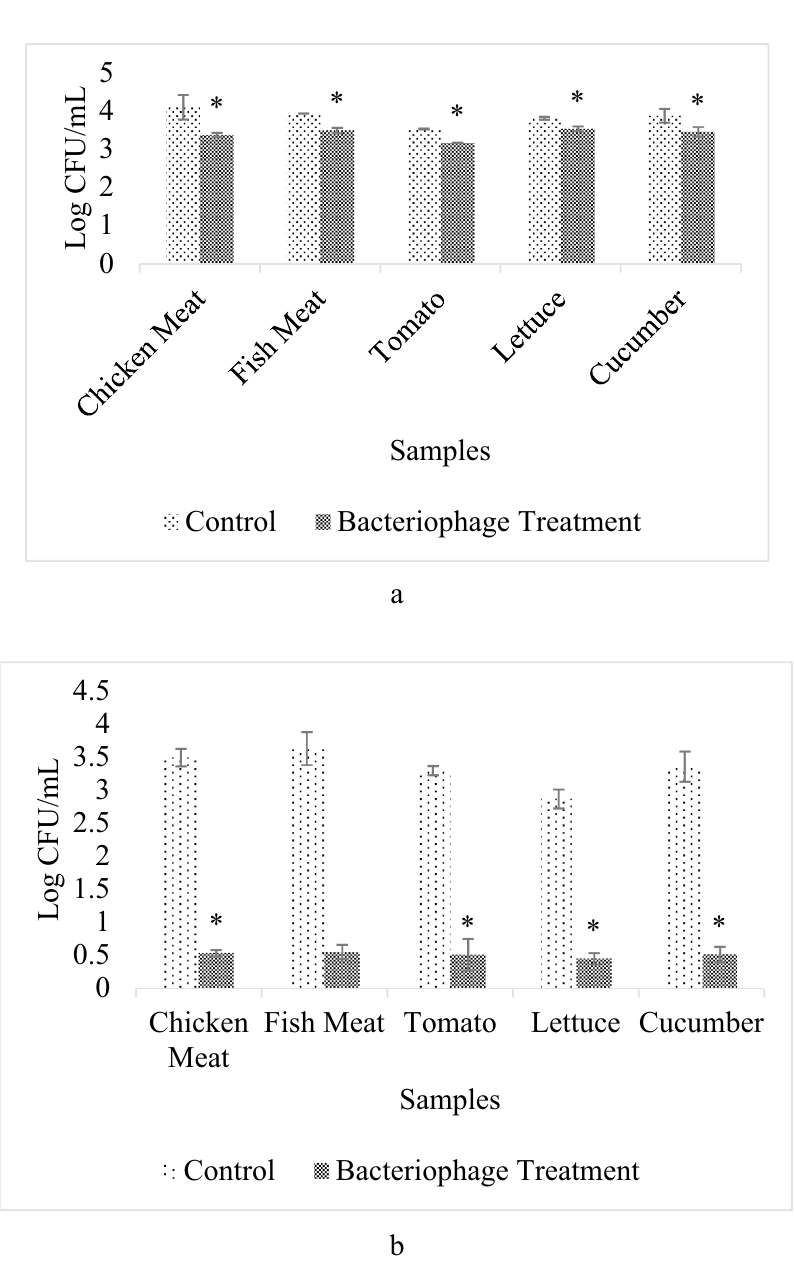
Figure 4. Bacteriophage DW-EC application on various food samples at 4 °C. With different time of incubation, which were for 1 day ( a ) and 6 days ( b ). “*”: Significant difference between the control and the treatment with P ≤